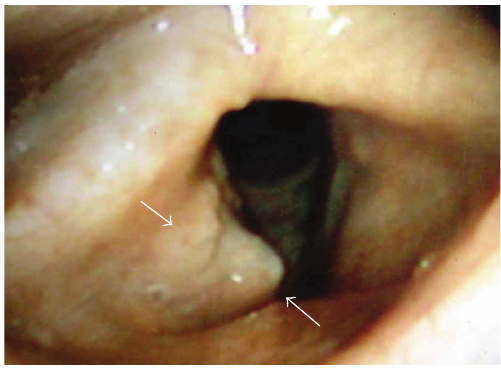
Figure 1: Flexible laryngoscopy showing an obtrusive tumor localized in the right false cord (arrows).